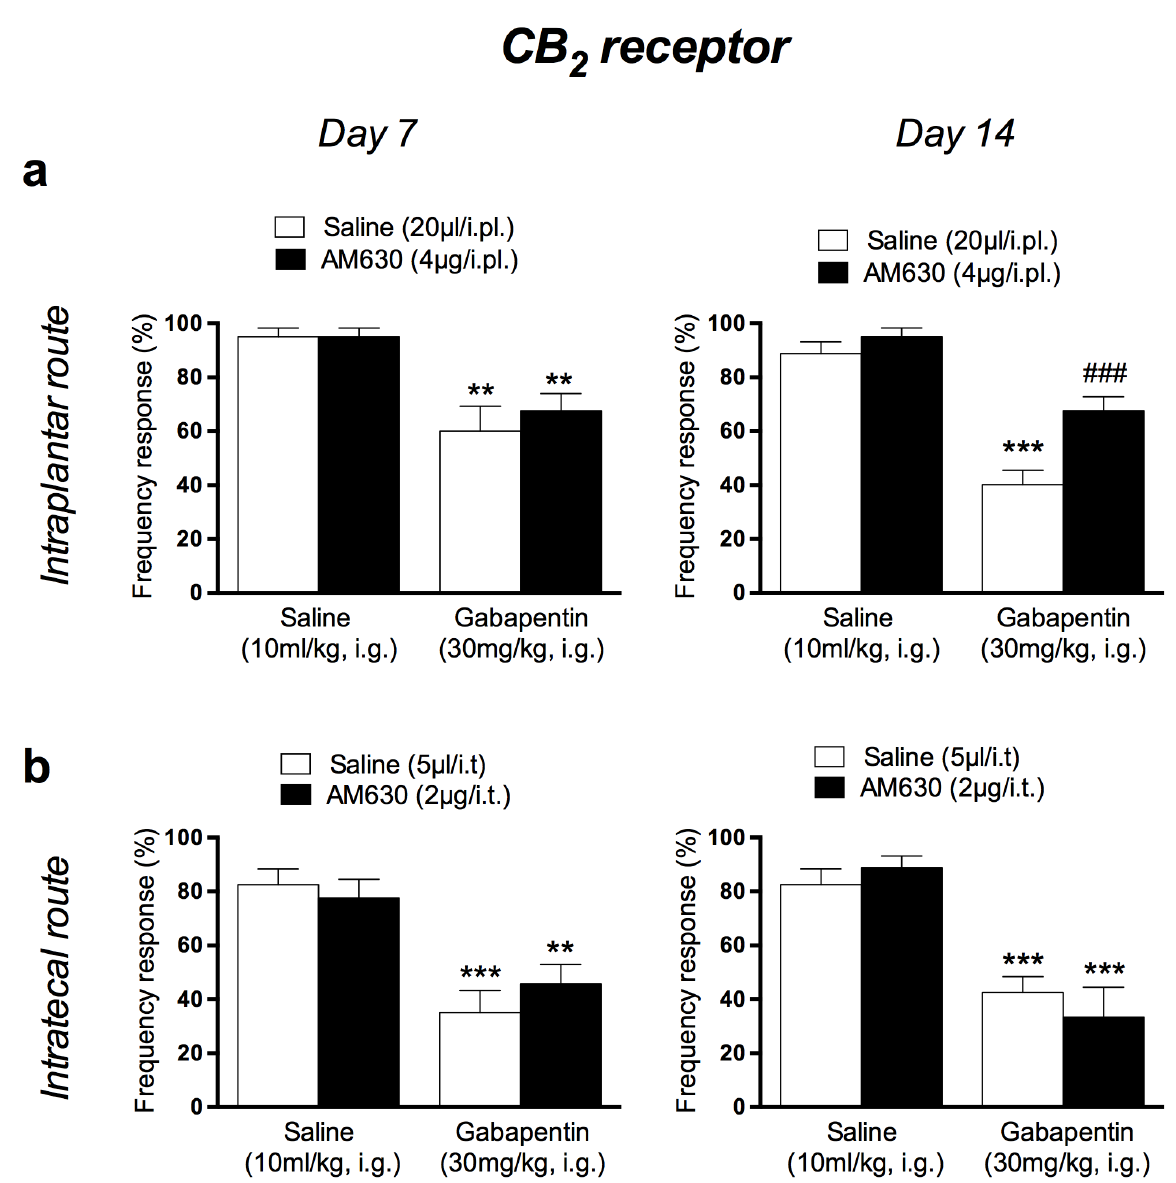
Figure 3. Influence of the CB antagonist, via i.pl. (panel A) or i.t. (panel B), on the antihyperalgesic effect of 2 gabapentin on the 7 th day and on the 14 th day after nerve injury induction in the PSL model in mice. Data are expressed as the mean ± standard error of the mean (SEM), n= 8 animals. (*) represents the comparison with the saline-saline group; (#) denotes the comparison with the salt-gabapentin group. Two-way ANOVA followed by Bonferroni, p<